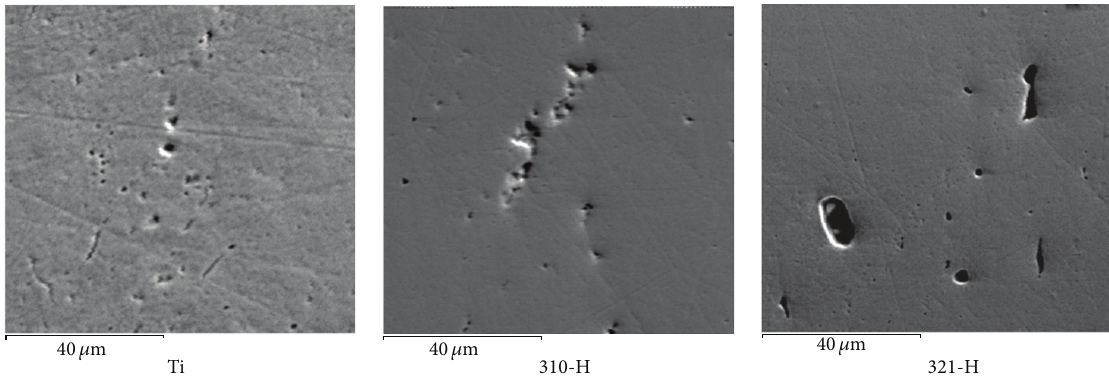
Figure 14: Superficial aspect of Ti, 310-H, and 321-H stainless steel after corrosion test in mouthwash